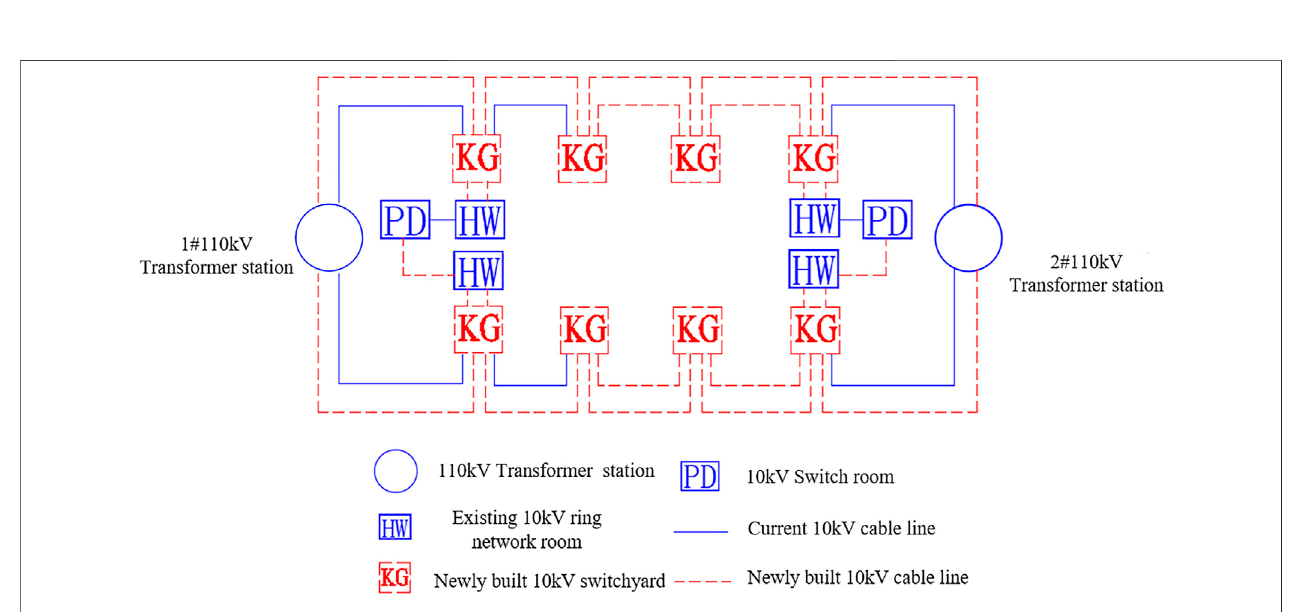
FIGURE 10 | The third wiring mode modi fi cation